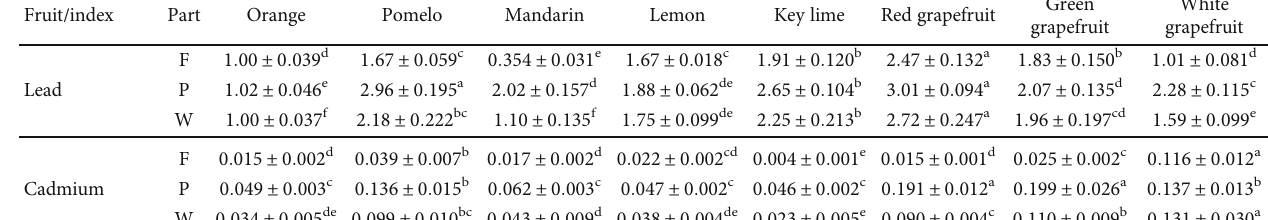
Table 5: Content of heavy metals ( μ g/100g) in citrus pulp (F), peel (P), and whole fruits (W). Fruit/index Key